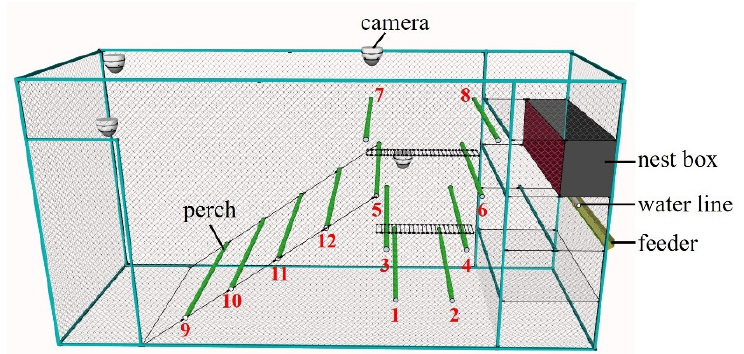
Figure 1. The schematic diagram of the perchery system (4.5 × 1.6 × 2.8 m (L × W × H)). Perches were numbered from 1 to 12 (Height: No. 1, 2: 400 mm; No. 3, 4: 800 mm; No. 5, 6: 1400 mm; No. 7, 8: 1800